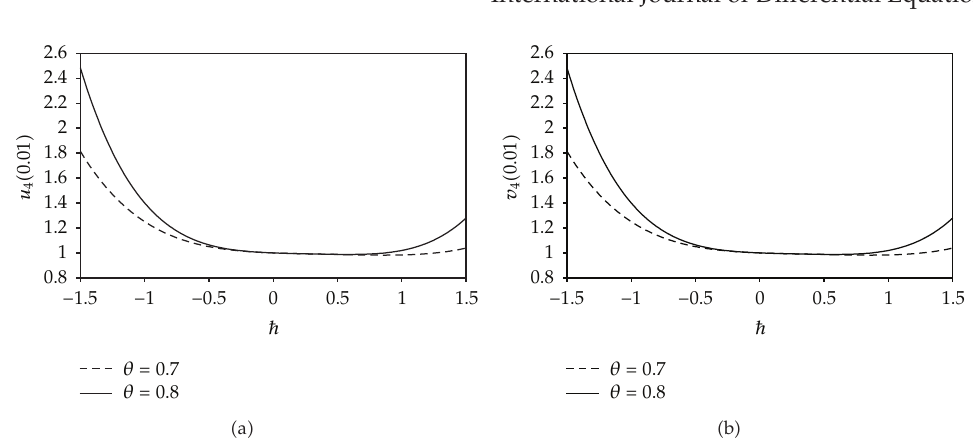
Figure 1: -curve for fractional biochemical reaction model using the third iteration MoSVIM with di ff erent (cid:0) value of θ , that is, (cid:3) 0 . 7 , 0 . 8 (cid:4)